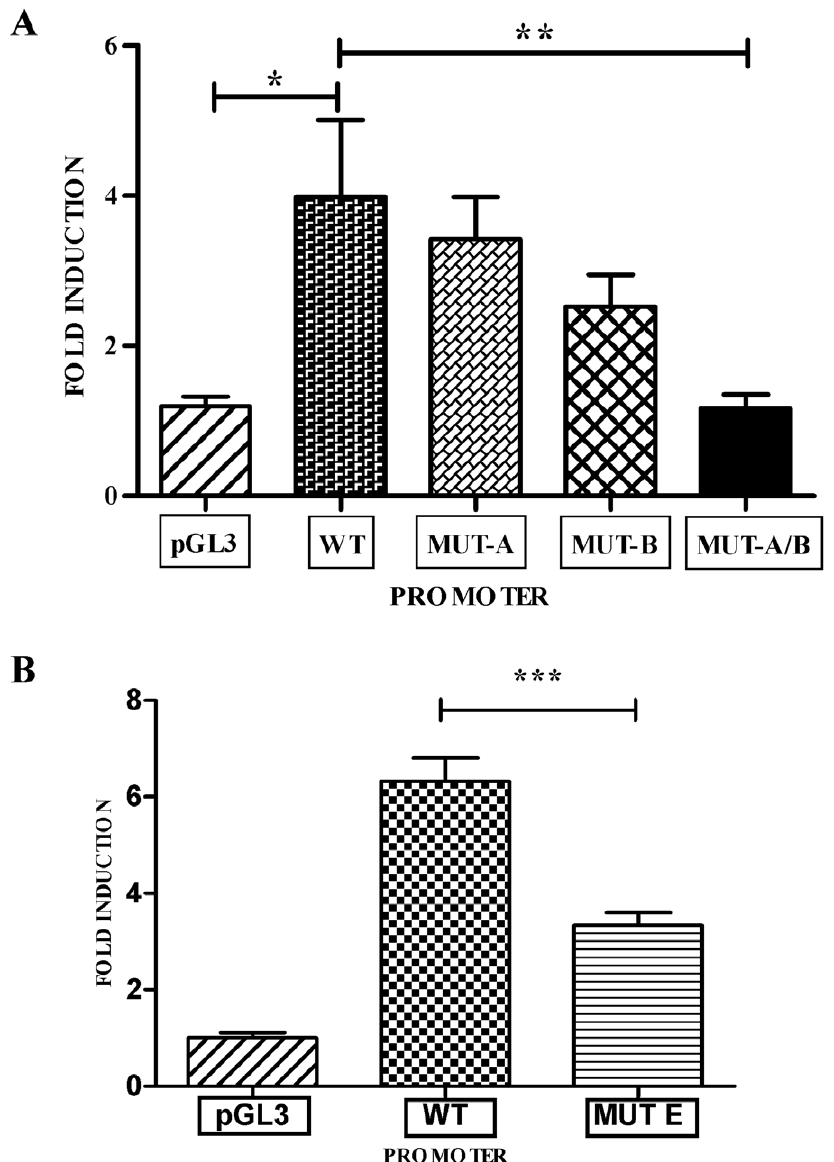
Figure 2. GLI Activators Induce Transcription at the Human TGF- b 1 Promoter. The human TGF- b 1 promoter region was placed into a pGL3- basic luciferase vector. (A) The three GLI binding sites within this region (Sites A, B, and C) were mutated separately or together (WT = wild-type TGF- b 1 promoter phTG5, MUT-A = site A mutation, MUT-B = sites B/C mutation, MUT-A/B = sites A/B/C mutation, pGL3= control vector). These TGF- b 1 promoter:luciferase constructs were co-transfected into 293T cells with the constitutive GLI activator (GLI2dN) and normalized to the negative control (pcDNA3). The GLI activator induced a four-fold increase of luciferase activity in phTG5 over the control. Mutation of both GLI binding sites (phTG5AB) abrogated this induction (n=10, *p=0.0011, ** p=0.0033). (B) The putative GLI binding Site E was mutated in the reporter plasmid phTG1 (WT = wild-type TGF-1 promoter phTG1, MUT-E = site E mutation, pGL3= control vector). The GLI activator induced a six-fold increase of luciferase activity in phTG1 over the control. Mutation of GLI binding Site E decreased this induction nearly two-fold (n=12, *** p=0.0025).